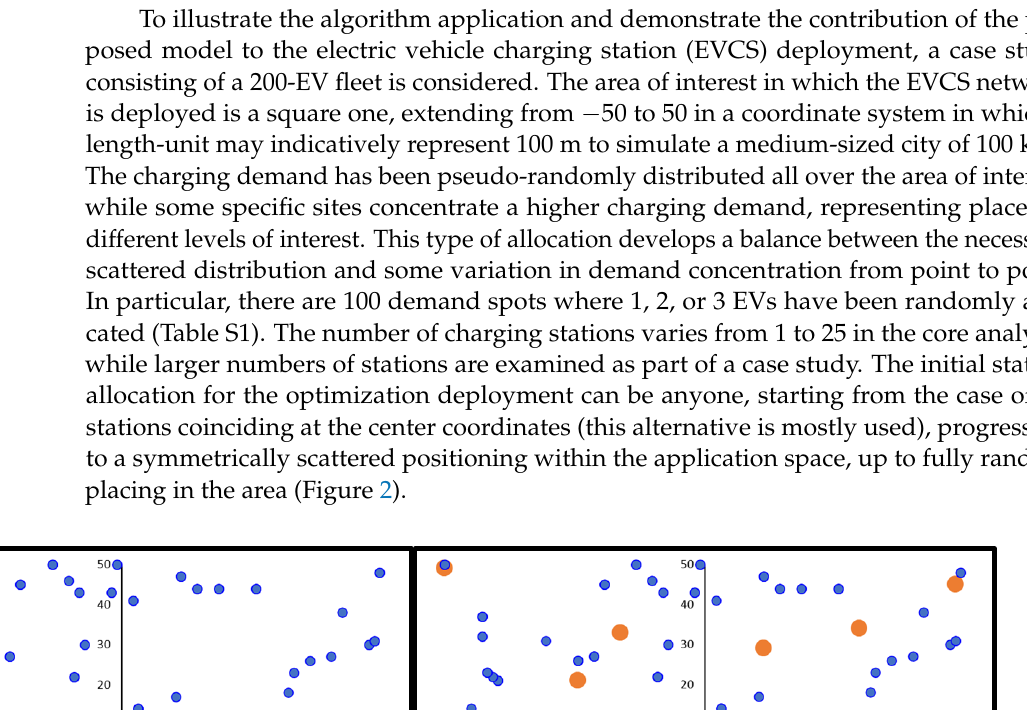
Table 1. Case study objectives and considerations .